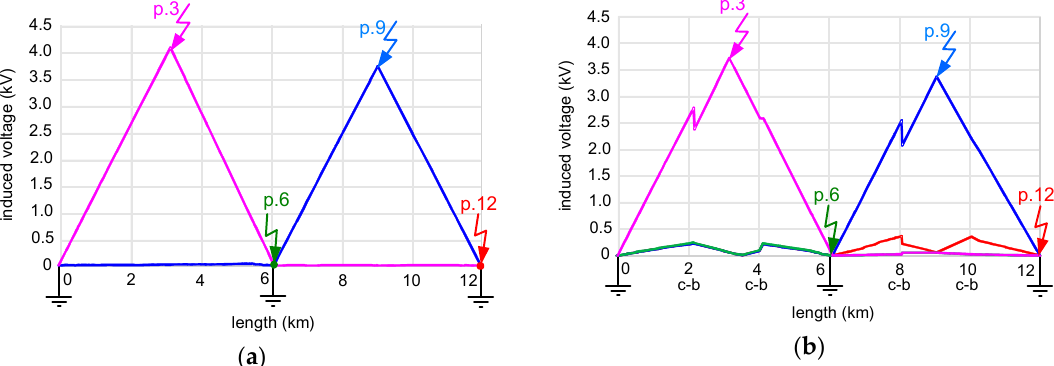
Figure 11. Induced sheath voltages as a function of the cable line length, in case of the line-to-earth fault in characteristic points (p.3, p.6, p.9 or p.12); additional earthing in p.6: ( a ) both-ends